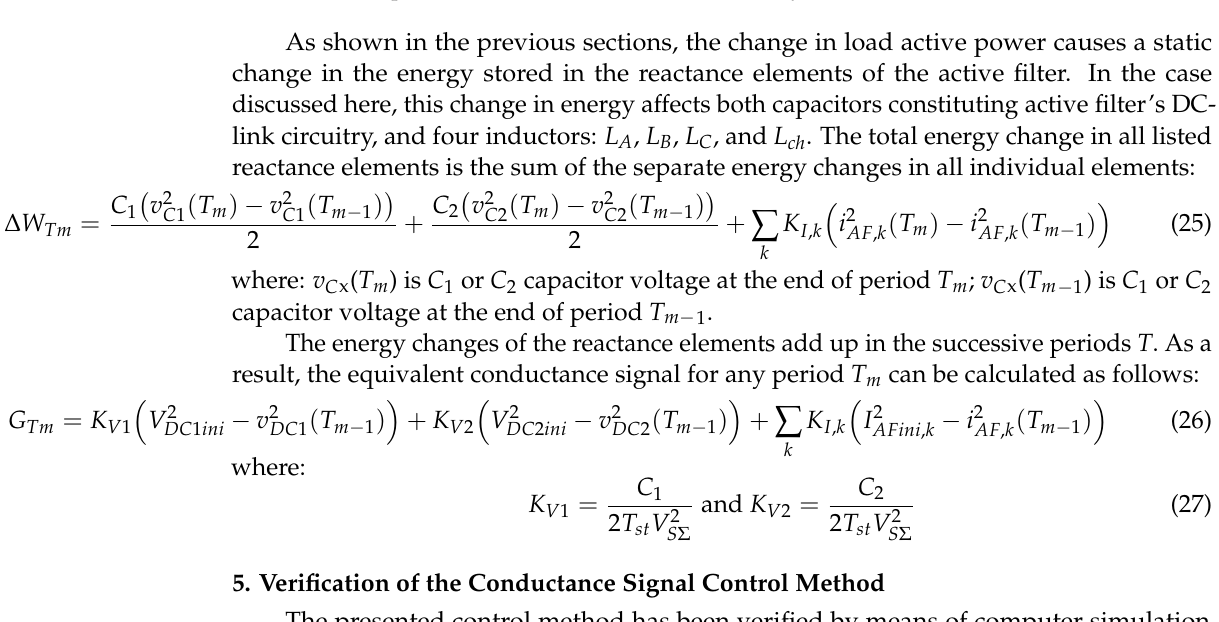
Figure 4. Three-phase four-wire source-line-load circuitry with active